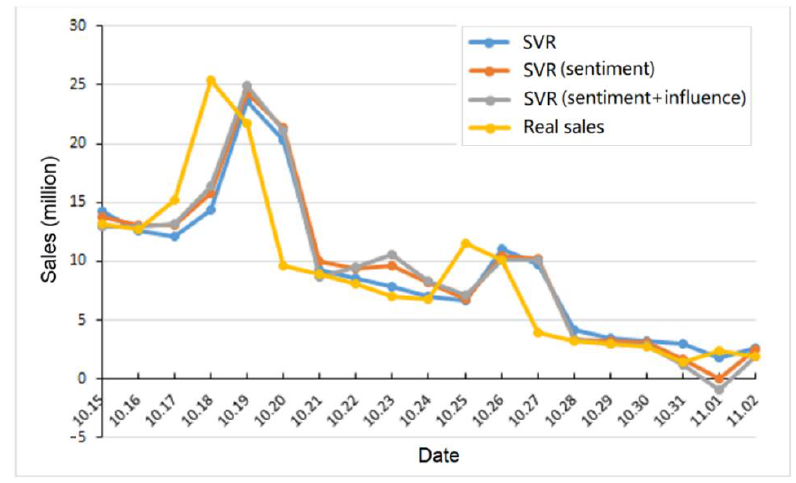
Figure 3. Prediction results of the SVR model with different features.